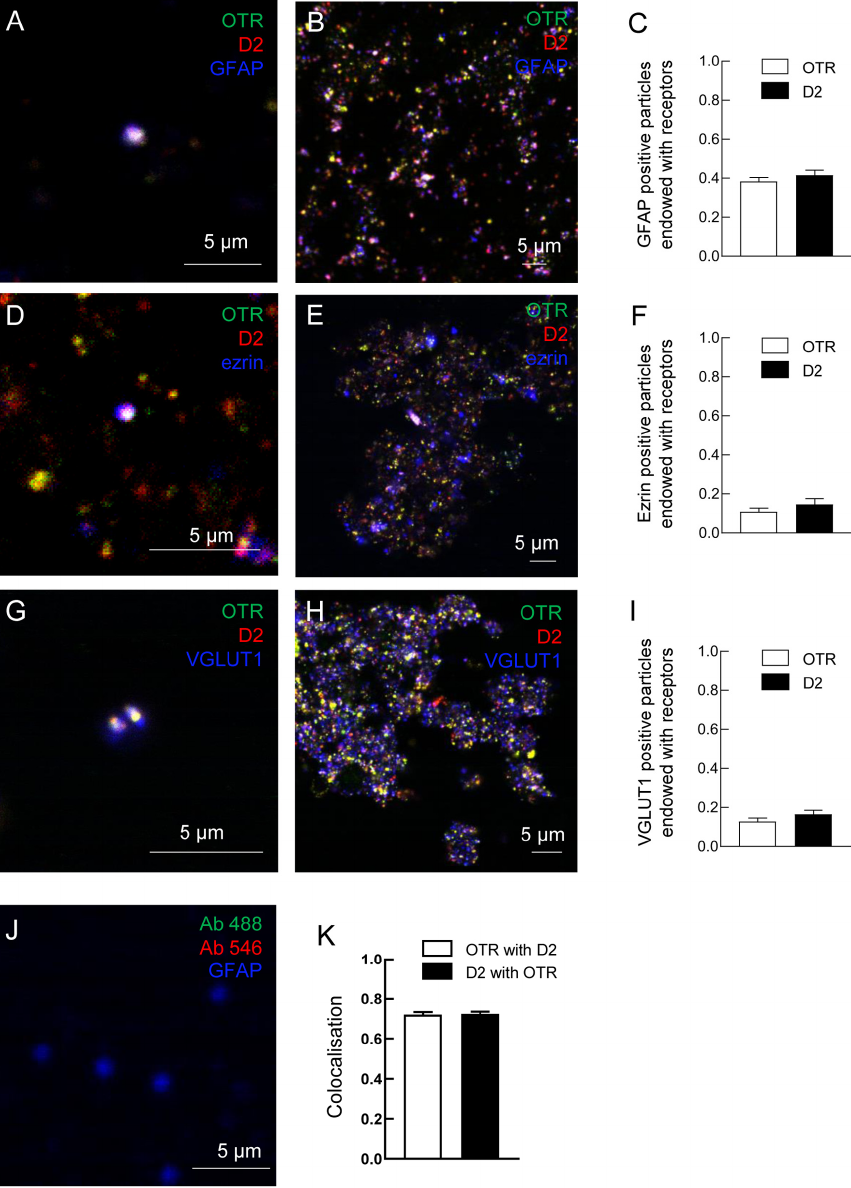
Figure 2. Striatal gliosomes co-express D2 and OT receptors. ( A – J ). Representative confocal images showing the co-localization of D2 and OT receptors on gliosomes. Triple immunofluorescence labeling in striatal gliosomes with antibody against the oxytocin OT receptor ( A , B , D , E , G , H , green), the dopamine D2 receptor ( A , B , D , E , G , H , red) and markers for the glial processes, GFAP ( A , B , J blue), or for the PAPs, ezrin ( D , E , blue), or for the vesicular glutamate transporter type 1, VGLUT-1 ( G , H , blue). Representative merged images are shown. Control images were acquired on samples in which the primary antibodies for OTR and D2 receptors were omitted ( J ). Note single gliosomes expressing OTR and D2 ( A , D , G ). The bars ( C , F , I ) indicate the percentage ( ± SEM of 12 fields from three different preparations) of GFAP ( C ) ezrin ( F ), and VGLUT1 ( I )-positive processes expressing OTR or D2. The bars ( K ) indicate the percentage ( ± SEM of 40 fields from ten different preparations) of co-localization between the receptors. GFAP, glial fibrillary acidic protein; OT, oxytocin; OTR oxytocin receptor; VGLUT-1, vesicular glutamate transporter type